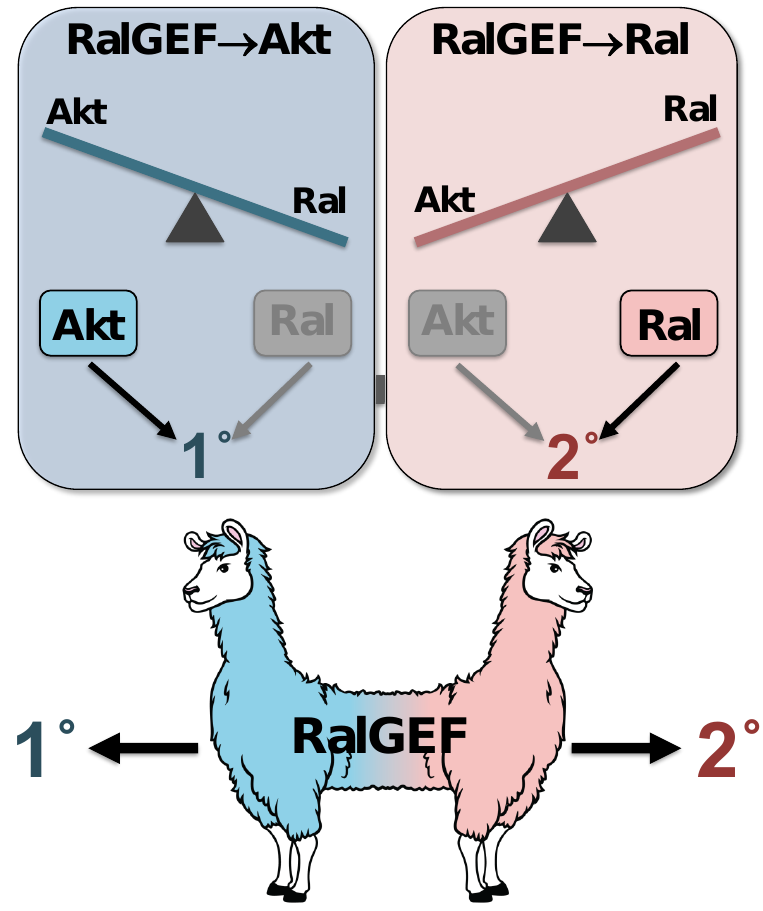
Figure 2. Insulated switches of dual function protein RalGEF RGL-1 during VPCs fate patterning. RalGEF RGL-1 functions in two modulatory cascades to promote both 1 ◦ and 2 ◦ fate. RalGEF RGL-1 is a sca ff old for PDK PDK-1 and Akt AKT-1 in the modulatory 1 ◦ -promoting PI3K AGE-1 cascade (light blue). And RalGEF RGL-1 promotes 2 ◦ fate via canonical GEF-dependent activation of Ral RAL-1 (light rose). A pushmi-pullyu animal is used as a metaphor for RalGEF RGL-1 protein that has dual function in promoting both 1 ◦ and 2 ◦